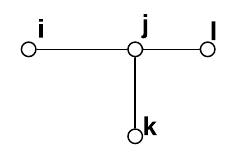
Figure 2. Sample 4 node